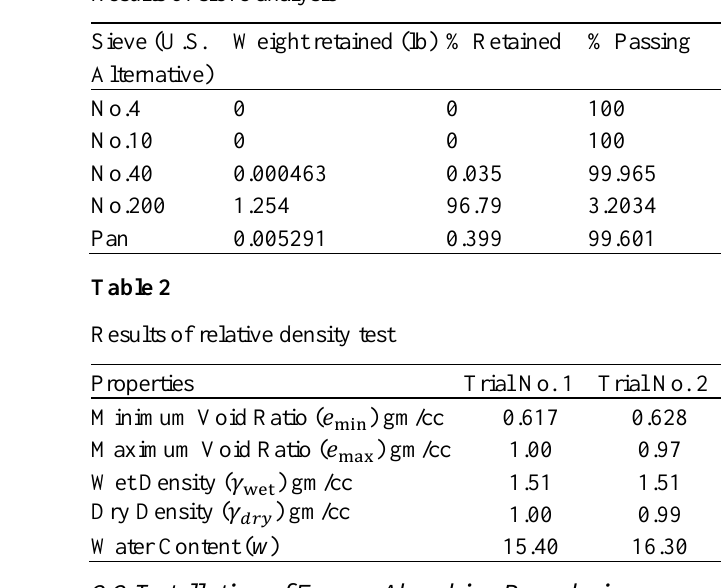
Results of sieve analysis